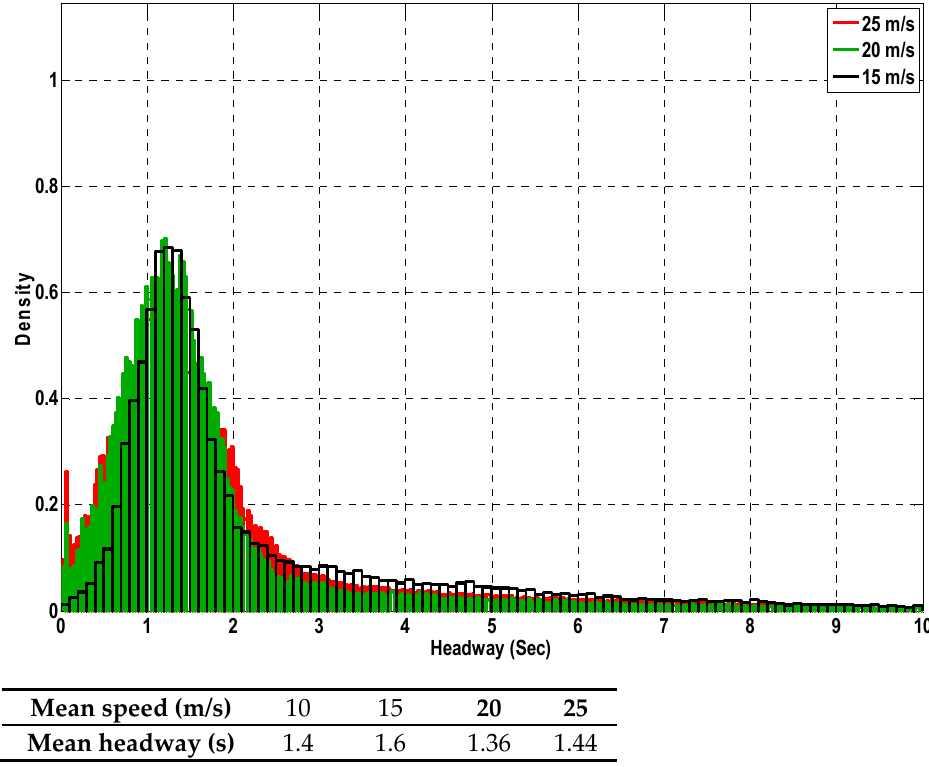
Figure 7. Headway distribution in the Aimsun simulation model for different range of speed.